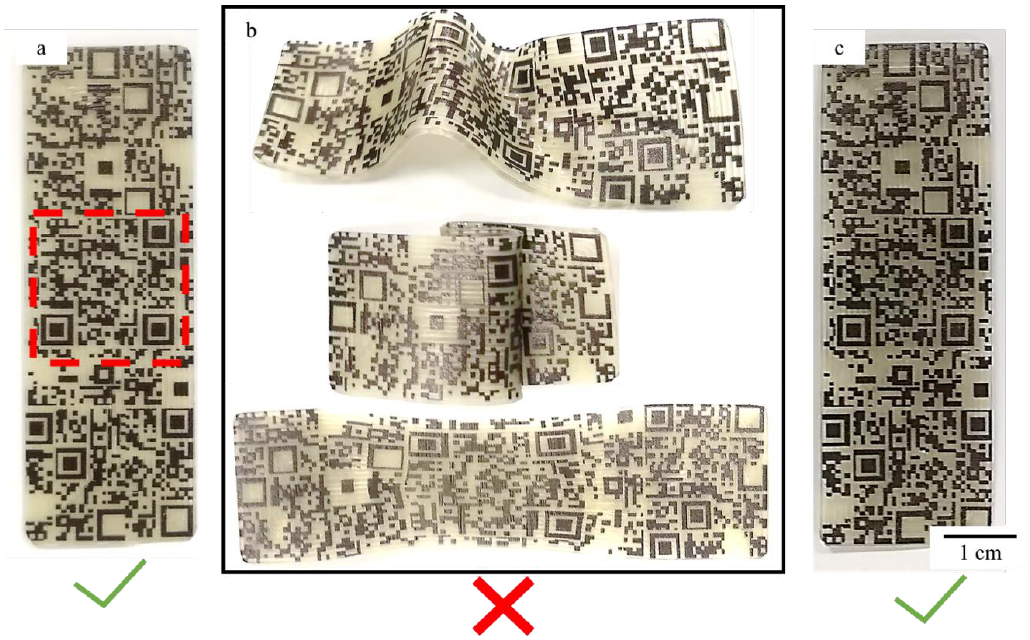
Figure 7. ( a ) SMP printed shape with printed QR-code (outlined in the red dashed square). ( b ) Samples after heating and deformation. ( c ) Recovery of the sample after heating.